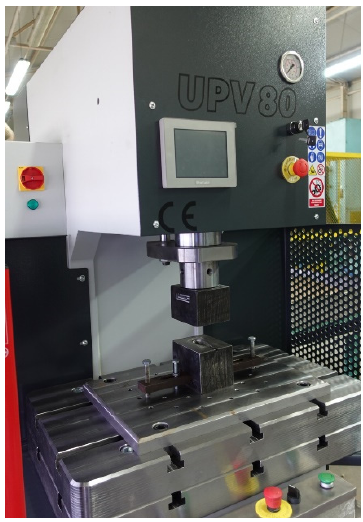
Figure 3. View of forming tool installed in UPV80 hydraulic press.